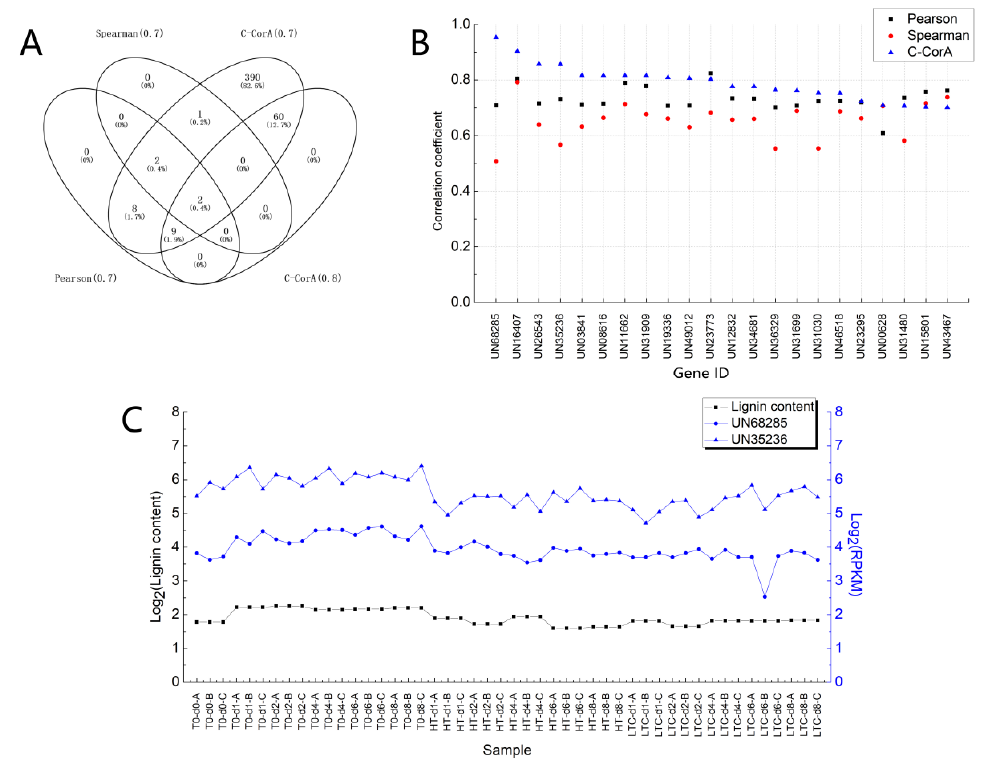
Figure 5. ( A ) A Venn diagram of the count of genes with high correlation coefficients in gene expression vs. lignin content comparison as calculated by the Pearson method, the Spearman method and the C-CorA method. ( B ) The correlation coefficients for 22 genes screened by the Pearson method or the Spearman method (>0.7) and the coefficients from the C-CorA method. ( C ) The base-2 logarithmic values of the RPKM values of genes UN68285 and UN35236.